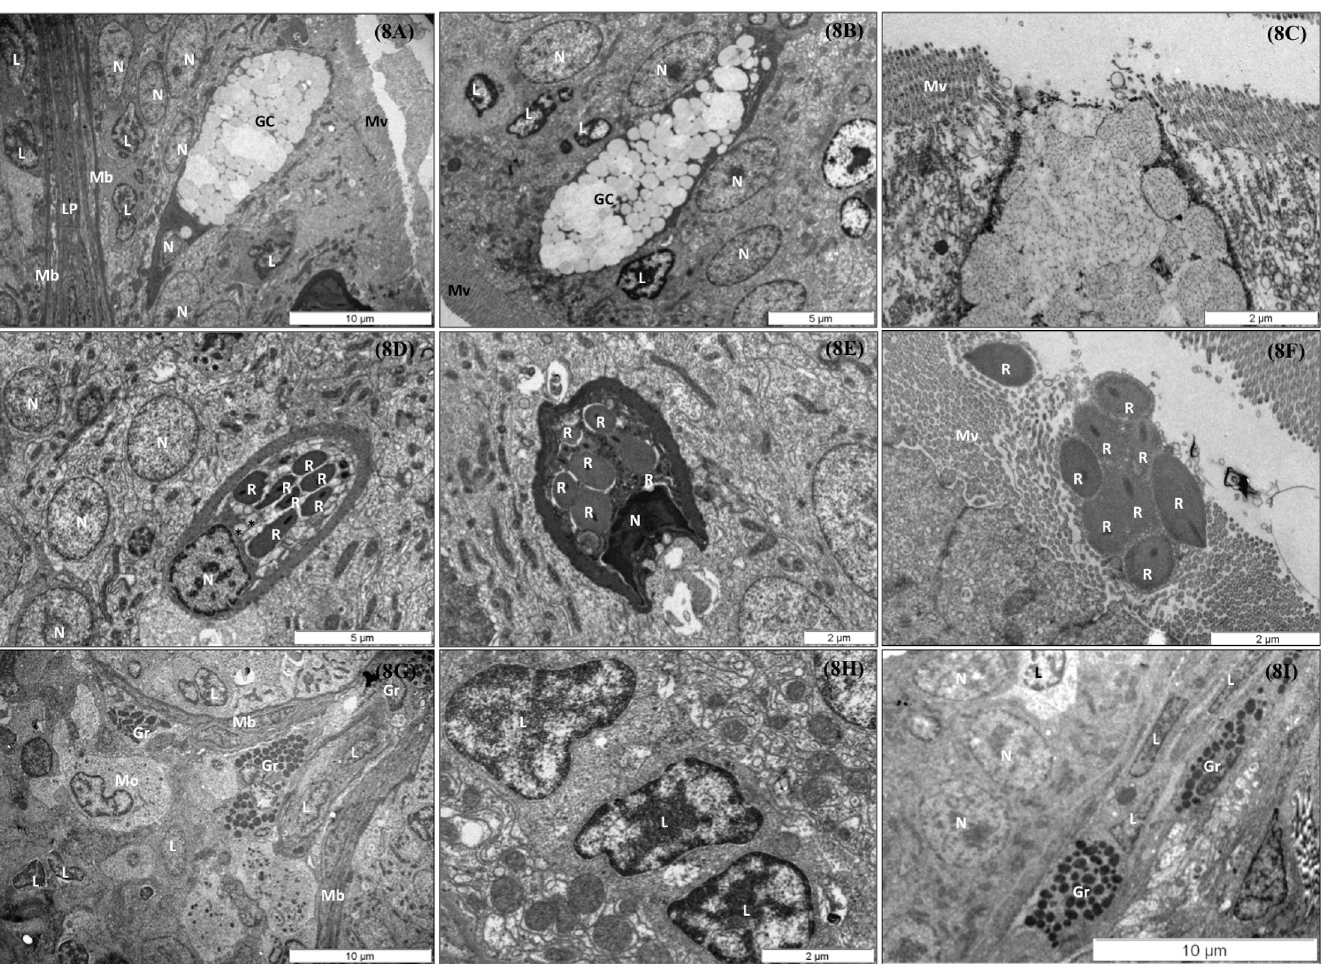
Fig 8. Detailed TEM micrographs of goblet cells, rodlet cells, lymphocytes, and eosinophilic granule cells (granulocytes) housed in the gut of European sea bass ( Dicentrarchus labrax ) juveniles. (A) Goblet cells scattered among enterocytes and characterized by a clearly polarized shape with narrow base containing the nucleus and organelles and an expanded apical region containing the secretory granules; observe granules with different electron density. Scale bar 10 μ m. (B) Goblet cells surrounded by lymphocytes. Scale bar 5 μ m. (C) Detail of goblet cell in process of mucus exocytosis inside the lumen. Scale bar 2 μ m. (D) Intraepithelial immature rodlet cell characterized by a single nucleus with condensed heterochromatin at nuclear periphery and a cytoplasm containing translucent vesicles ( � ) and rodlets (R) with electron dense cores. Orientation in parallel to the surface layer of the epithelium. Scale bar 5 μ m. (E) Intraepithelial mature rodlet cell oriented perpendicular to the surface layer of the epithelium. Scale bar 5 μ m. (F) Free rodlet bundles in the microvilli. Scale bar 2 μ m. (G) Representative micrograph of leukocytes housed in the intestinal submucosa. Scale bar 10 μ m. (H) Detail of lymphocytes characterized by a single nucleus with areas of condensed heterochromatin. Scale bar 2 μ m. (I) Representative micrograph of granulocytes housed in the lamina propia. Scale bar 10 μ m. Abbreviations used are: GC: Goblet cell; Gr: granulocyte; L: Lymphocyte; LP: Lamina propria; Mb: Basal membrane; Mo: Macrophage; Mv: Microvilli; N: Nucleus; R: Rodlet. https://doi.org/10.1371/journal.pone.0222063.g008 Gene expression analyses. Fig 9 shows the transcript levels of tight junction ( Ocln , ZO-1 ), adherens ( Cad-17 , E-Cad ), desmosomes ( N-Cad ), and cytoskeletal ( α -Tub and Vim ) genes in the posterior gut of European sea bass at the end of the feeding trial (63 days). One-way ANOVA analyses showed no influence of dietary treatment on the mRNA copies of Ocln , ZO- 1 , Cad-17 , E-cad , α -Tub , and Vim genes. In contrast, the expression level of N-Cad was increased (p < 0.05) by GMOSPHYTO diet supplementation (Figs 9 and S1 Fig). Two-way ANOVA analyses found a statistically significant increase (p � 0.10) in transcript copies for Ocln , N-Cad and Cad-17 to PHYTO diet at the end of the feeding trial (F = 3.299; ocln p = 0.87; F = 15.861; p = 0.001; F = 2.415; p = 0.130). No significant effect due to N-Cad Cad-17